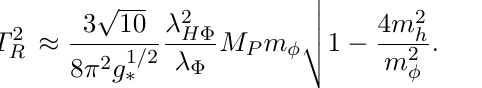
Figure 5 . Comparisons of the pNGB dark matter yields, Y IR for λ = 10 − 7 and λ = 10 − 11 . The reheating temperature is given by eq. (4.12) in the left panel H Φ Φ and a free parameter in the right panel, chosen as T smoothly connected in the gray region, typically T